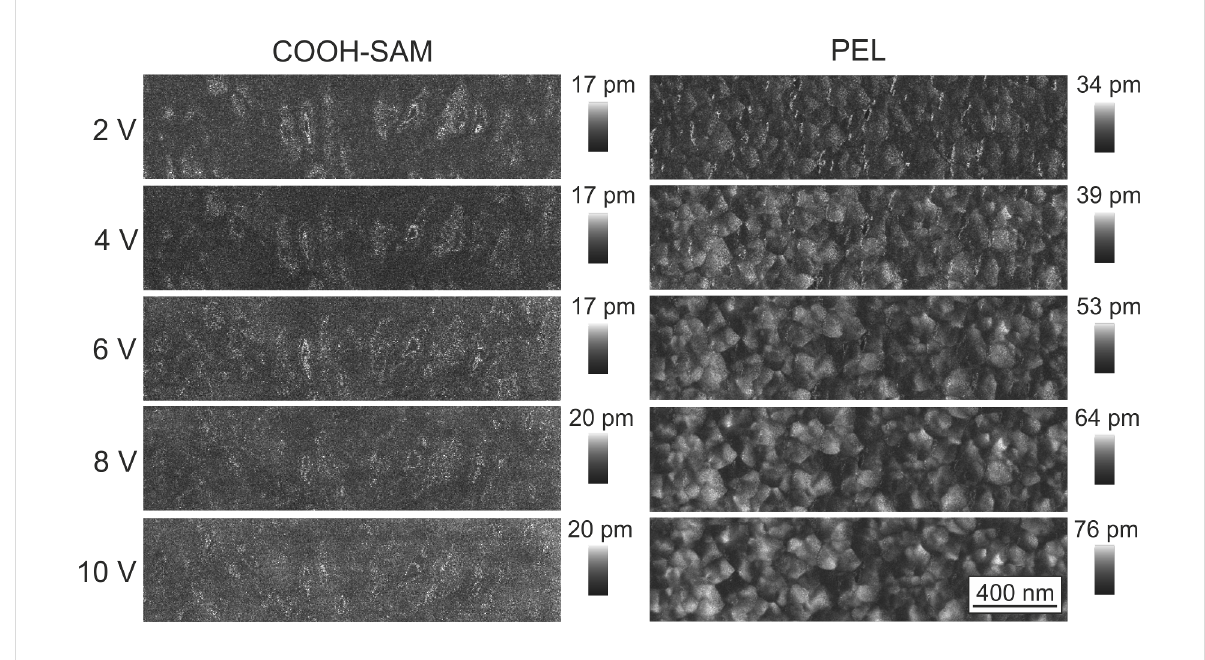
Figure 4: PFM amplitude 1 images obtained by applying voltages of 2 to 10 V of the deposited films on COOH-SAM (left) and PEL (right). The scan area for all images is 2 µm × 0.5 µm.